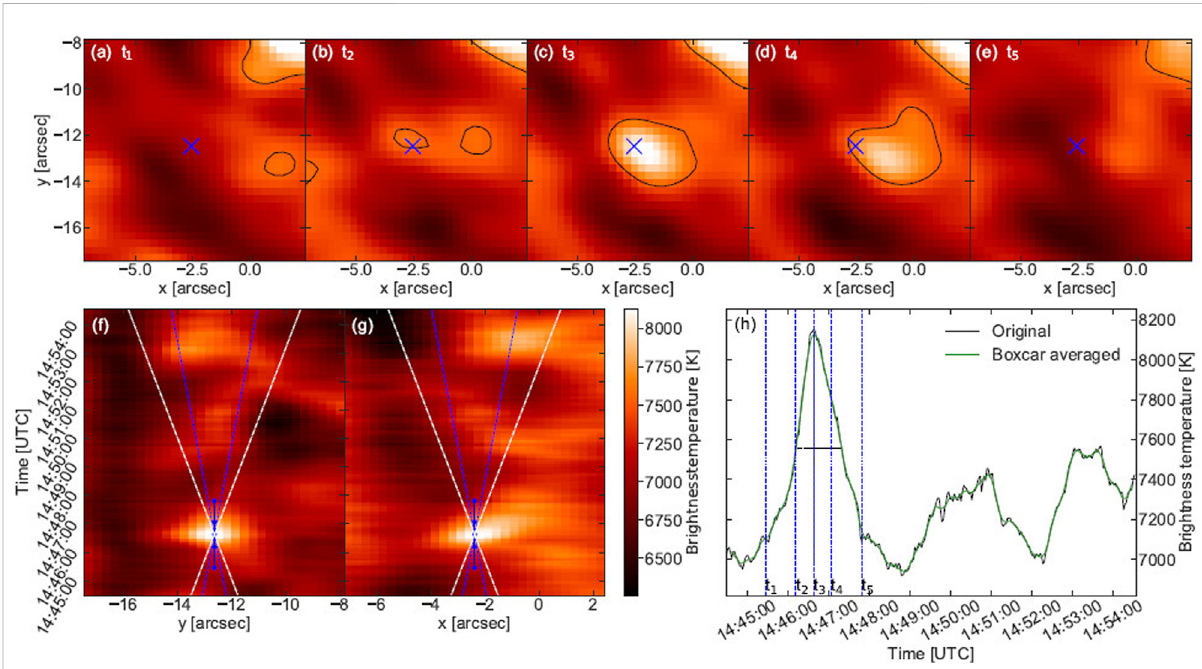
FIGURE 14 Panels (A – E) showcharacteristicsnapshotsofatransientbrighteningattributedtoapropagatingshockwave.Thecenterofthe fi eldofviewismarked bytheblue “ x. ” Panels (F , G) showverticalandhorizontalcuts,respectively,acrossthecenterofthe fi eldofviewwhichisindicatedbybluedotsforthetimesof panels (A – E) .Blueandwhitelinesindicateapparentvelocityslopesfor10and20 km s − 1 ,respectively.Panel (H) showsthebrightnesstemperaturetimepro fi le of the center of the fi eld of view (from Eklund et al., 2020). Reproduced with permission ©